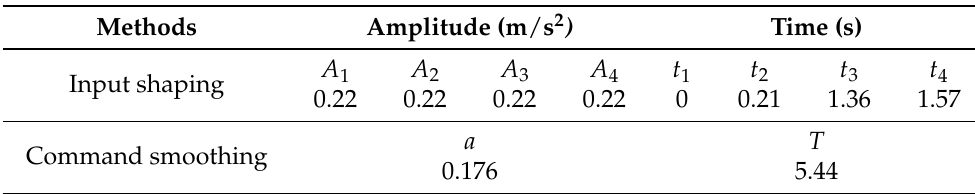
Table 3. Parameters of the input shaping and command